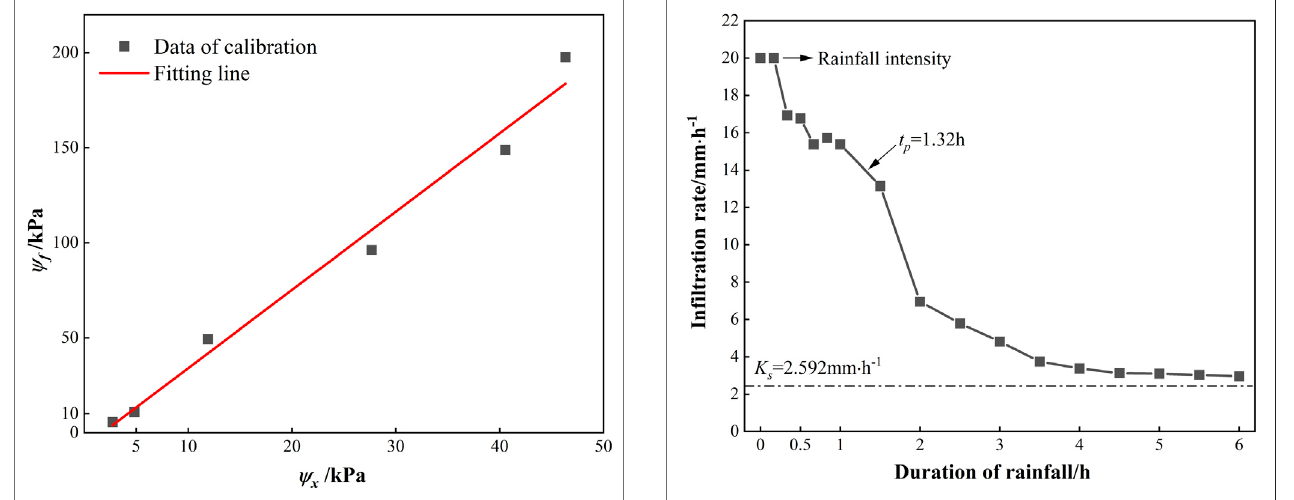
FIGURE 14 | Time-history curve of in fi ltration